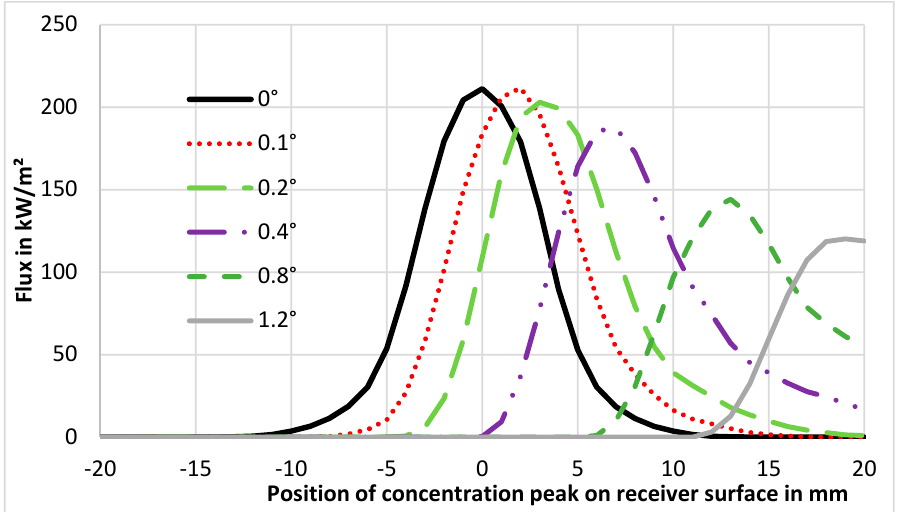
Figure 11. Position of the maximum concentration peak over receiver surface depending on tracking error.